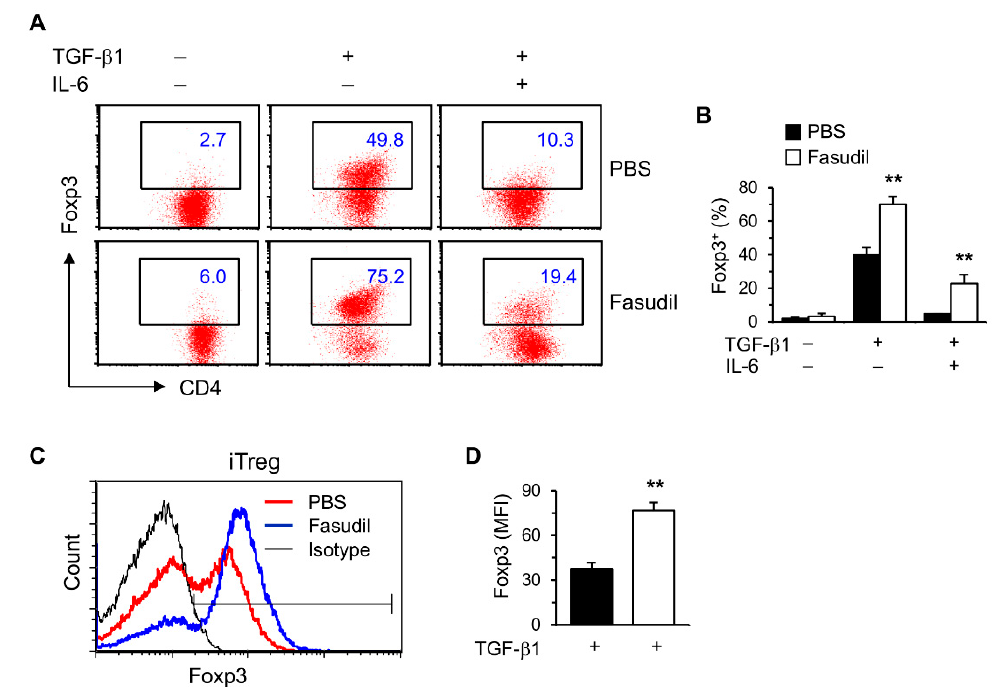
Figure 4. Fasudil upregulates iTreg cells. Naïve CD4 + T cells were di ff erentiated under Th17 / Treg conditions for 4 days and restimulated with PMA plus ionomycin for 5 h in the presence of vehicle (PBS) or fasudil (30 µ M) throughout the culture. Cells were collected for Foxp3 intracellular staining. Percentages of Foxp3 + CD4 + T cells are shown in ( A ) representative dot plots and ( B ) summarized in a bar graph. ( C ) Under iTreg conditions with TGF- β 1, the mean fluorescence intensity (MFI) of Foxp3 is shown in a histogram gated on CD4 + T cells. ( D ) The MFI of PBS versus fasudil-treated groups is summarized in a bar graph. Data (mean + SD of triplicates) are representative of two independent experiments. ** p < 0.01 compared with PBS-treated groups.